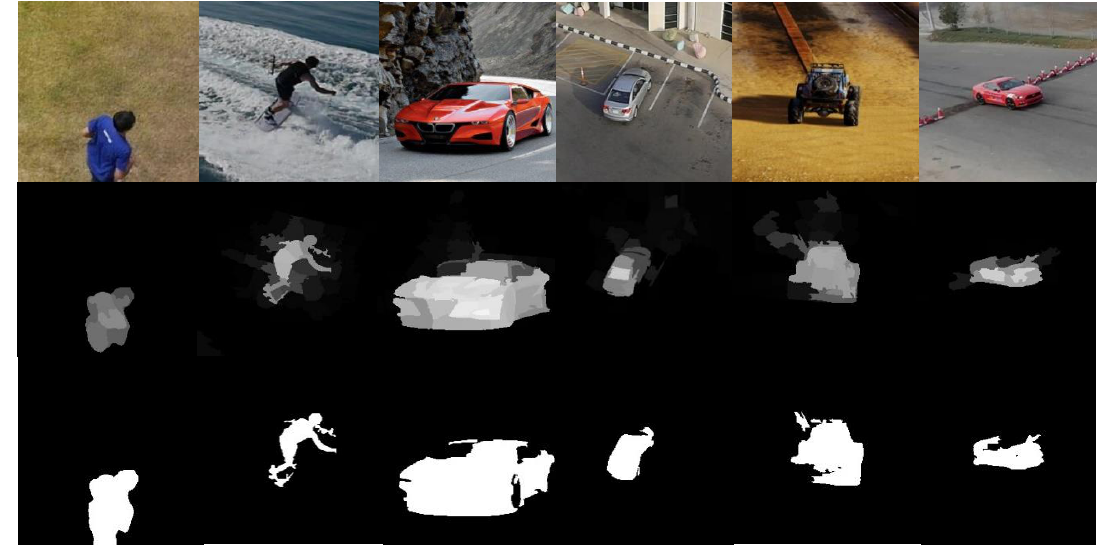
Figure 1. There are original images in the first row, saliency map in the second, binary saliency maps in the third Component 𝐸 𝑓𝑔 defines foreground or object